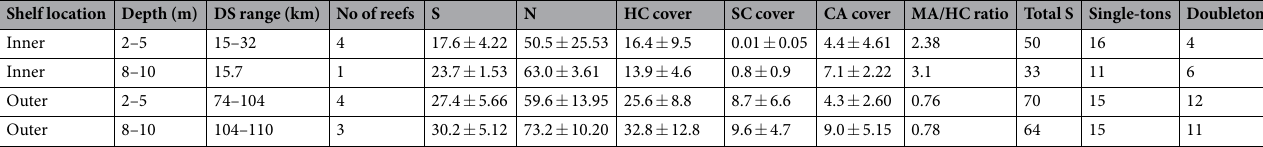
Table 2. Mean percentage ( ± SD) of benthic richness (S), cover (N), and coral and coraline algae cover in inner and outer-shelf reefs at both depth